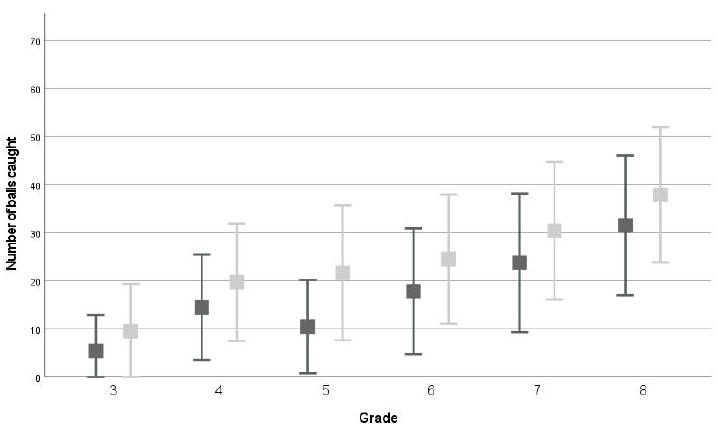
Figure 3. Average and standard deviation on moving sideways test at T0 (dark grey) and T1 (light grey).